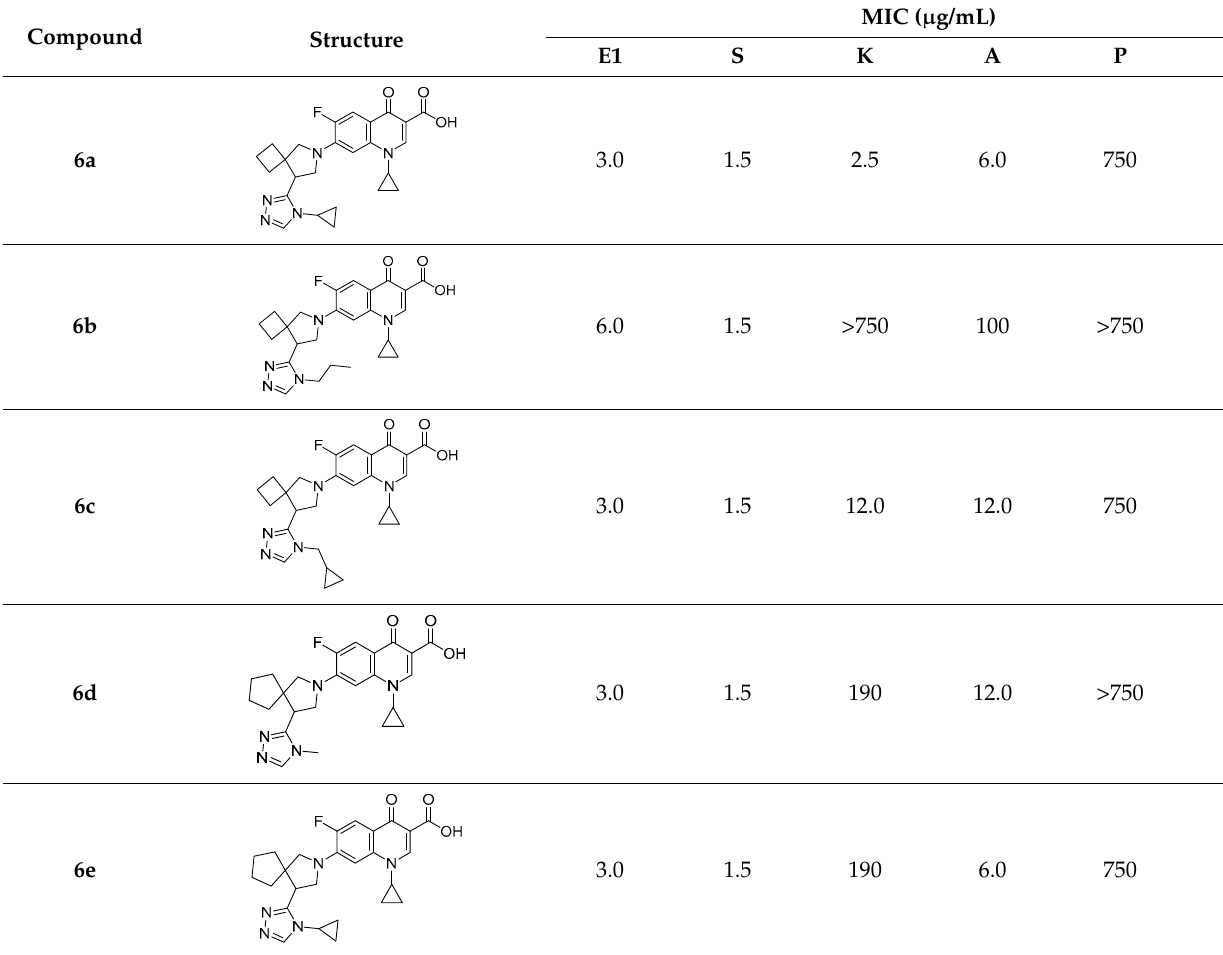
Table 1. Antibacterial activity as minimal inhibitory concentration (MIC, µg/mL) of compounds 6a– k as well as ciprofloxacin (positive control) against the ESKAPE panel of pathogens (E1 = Enterobacter cloacae (G − ), S = Staphylococcus aureus (G+), K = Klebsiella pneumoniae (G − ), A = Acinetobacter baumannii (G − ), P = Pseudomonas aeruginosa (G − ), and E2 = Enterococcus faecalis (G+)); NT—not tested (the disk diffusion inhibition zone diameter did not warrant MIC determination). The MIC values are mean from three different assays (errors were in the range of ± 5–10% of the reported values). Compound 3w from [18] is provided as a comparison. The antibacterial activity of the lead compound ( 6a ) is underscored. MIC ( µ g/mL) E1